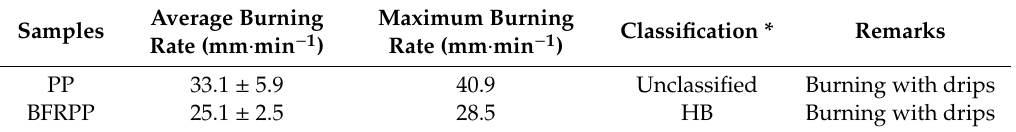
Table 5. Results of UL-94 horizontal burning test for PP and BFRPP.